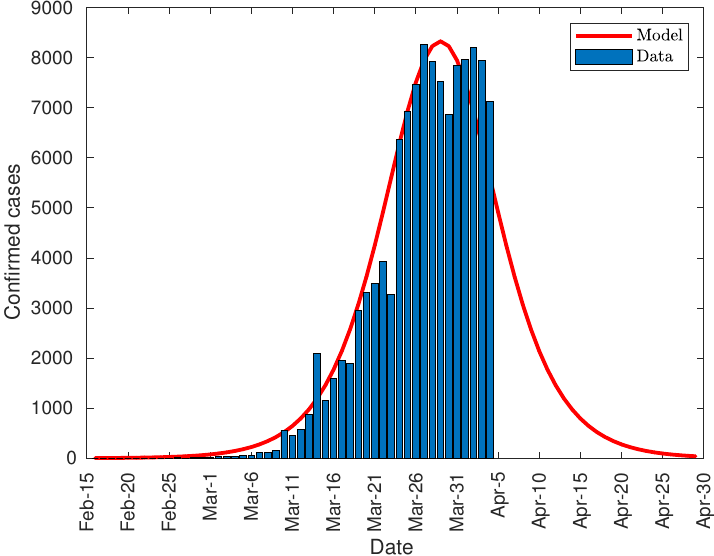
Figure 13. Number of daily diagnosed cases in